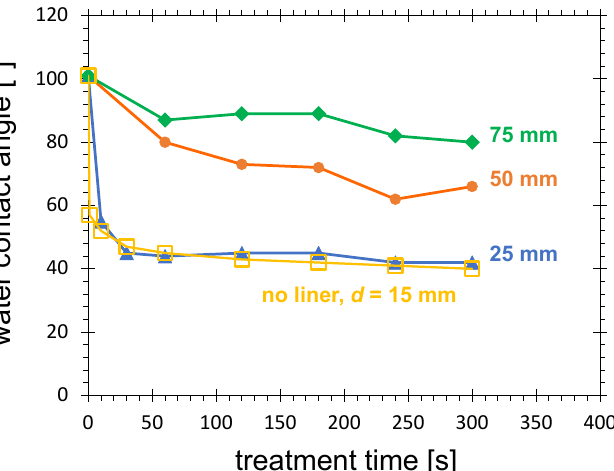
Figure 11. Water contact angle measured at the HDPE substrate surface after nitrogen PDD treatment as a function of treatment time for 3 different lengths of the plasma liner extension, and without plasma liner at 15 mm, as specified in the diagram, and the distance between the plasma liner extension and the substrate of 2 mm. Further treatment parameters are the PCPG input power of 8.0 W, and the gas flow of 10.0